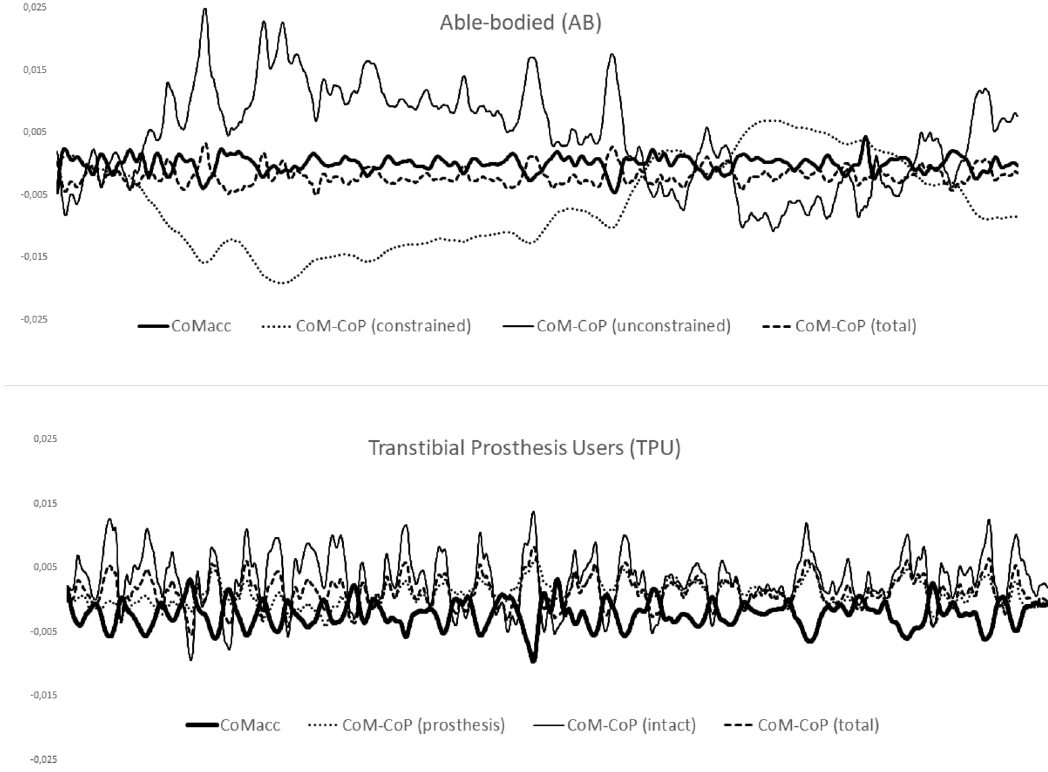
Figure 2. 30-s representative time curve for the sagittal plane (anteroposterior) for the able-bodied group (AB) and the transtibial prosthesis user group (TPU). Outcomes in the curve are centre of mass acceleration (CoM Acc ), difference between the position of the centre of mass and centre of pressure (CoM-CoP) for each of the three sides of interest (prosthetic limb/constrained for AB group), intact limb/unconstrained for AB group, and total). Given the coordinate system utilized (positive = anterior), negative values indicate the CoM is posterior to the